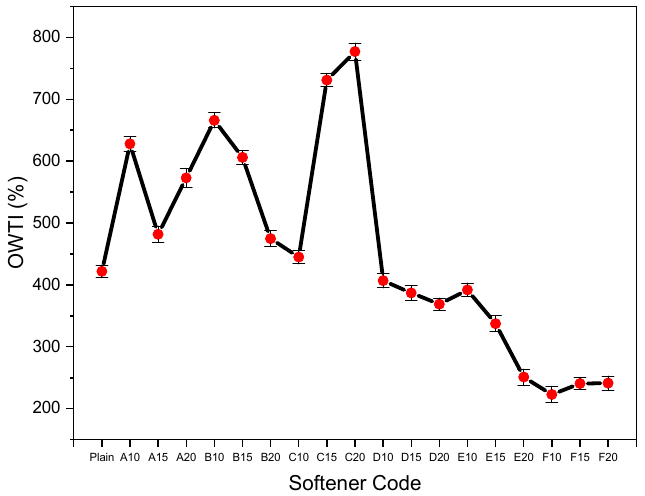
Figure 4. Spreading speed of liquid of the terry knitted fabric with the application of different softeners.